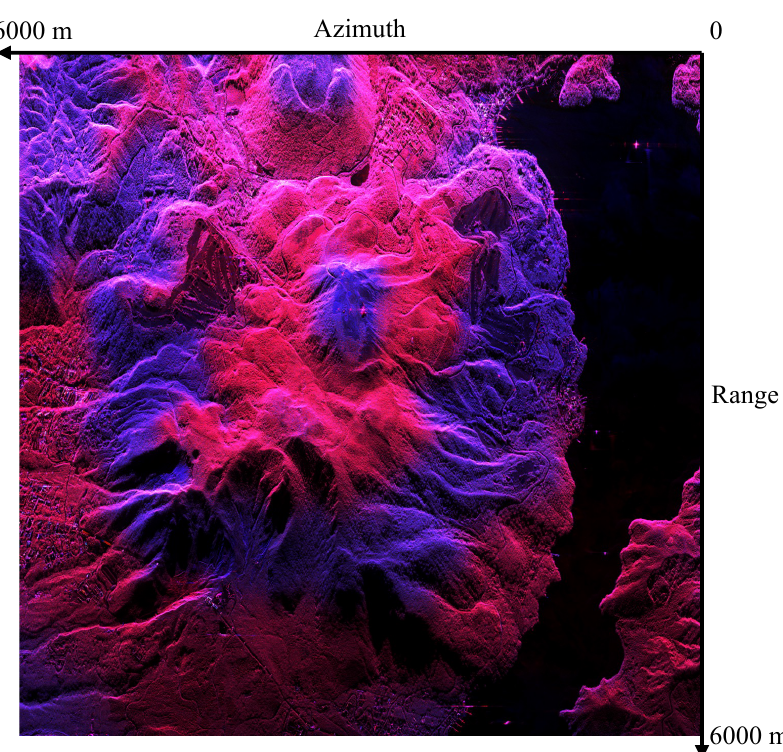
Figure 9. G4U image before calibration around Mount Hakone on 3 December 2015 (Center: N35.218, E139.031).